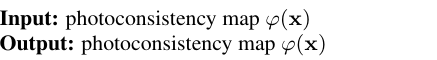
Algorithm 1 V ISIBILITY S PURIOUS P OINTS R